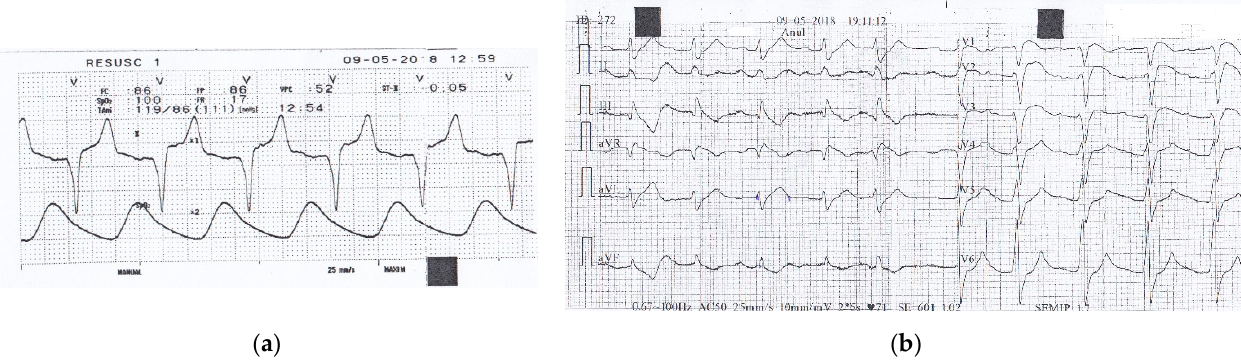
Figure 1. ( a ) Monitor recording during transportation to the first hospital shows a sinus rhythm of 86/min, a prolonged PR interval of 240 msec with normal QRS complex of 110 msec.; ( b ) 12-lead ECG recorded in the local hospital, 3 h after the ingestion of drugs, shows irregular sinus rhythm of 71/min, with a prolonged PR interval of 280 msec, a wide QRS complex of 160 msec, and slightly prolonged QTc interval of 479 msec.